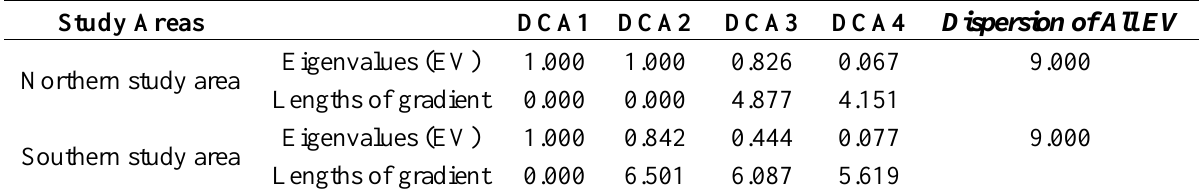
Table 7. Summary table of DCA applied to vegetation training